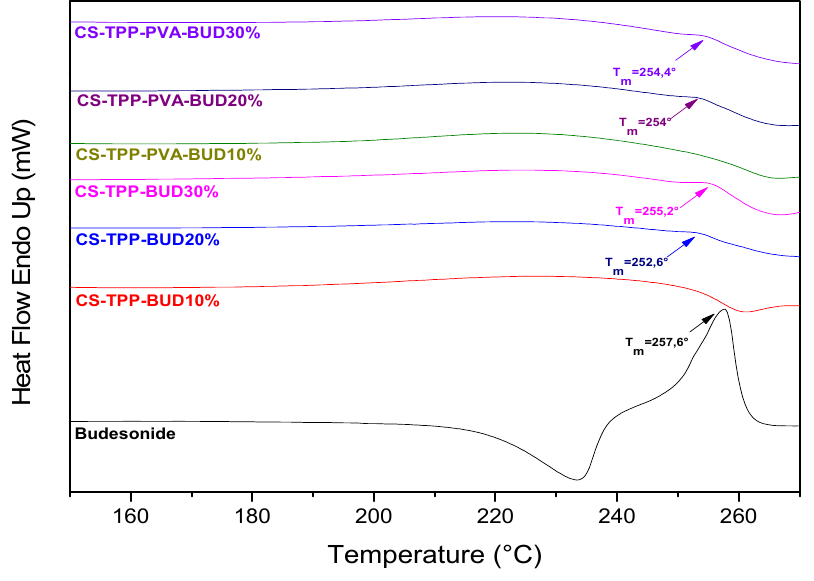
Figure 6. DSC curves of chitosan nanoparticles containing BUD.